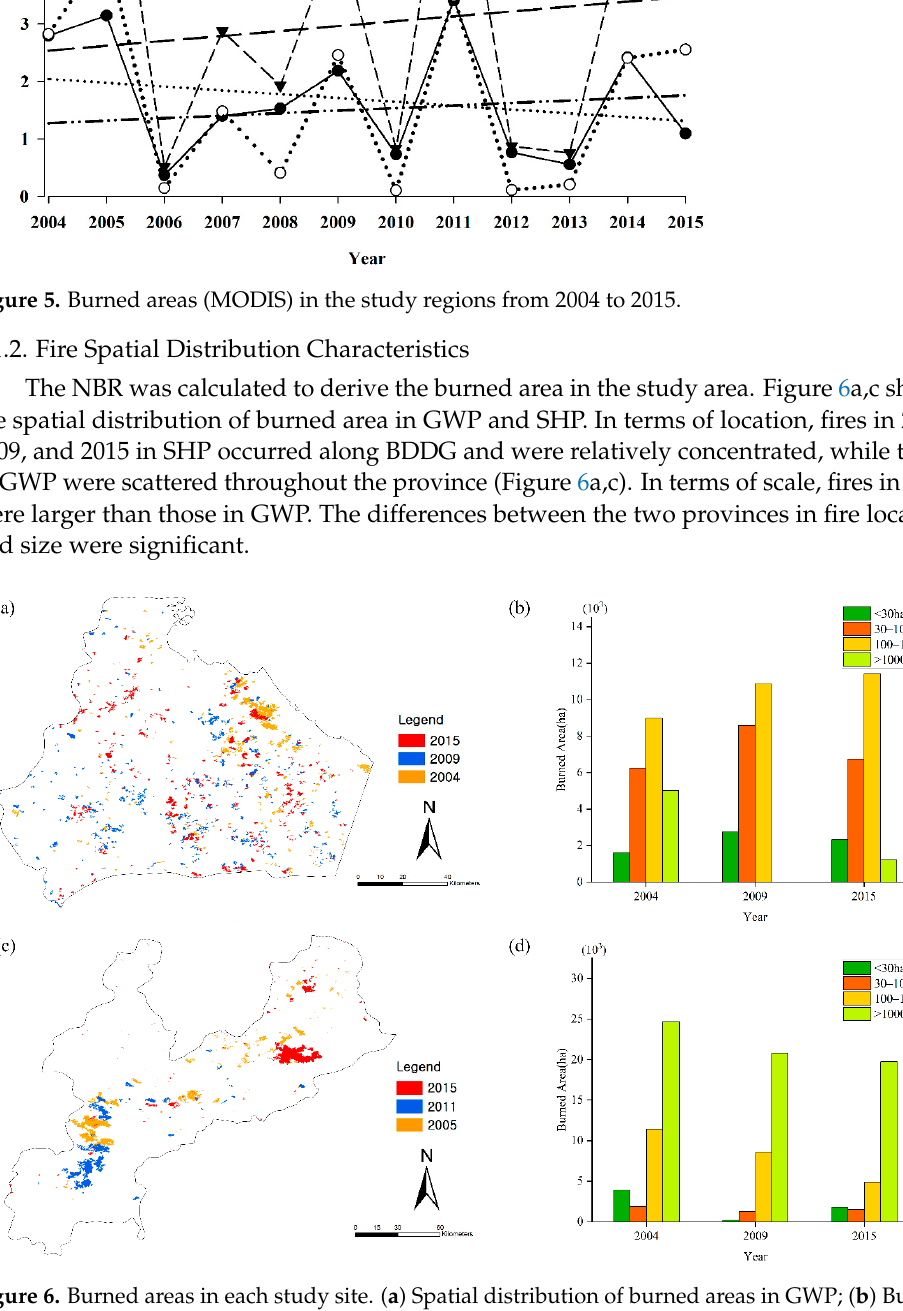
Figure 6. Burned areas in each study site. ( a ) Spatial distribution of burned areas in GWP; ( b ) Burned areas in GWP for three years (Unit: ha); ( c ) Spatial distribution of burned areas in SHP; ( d ) Burned areas in SHP in three years (Unit: ha).